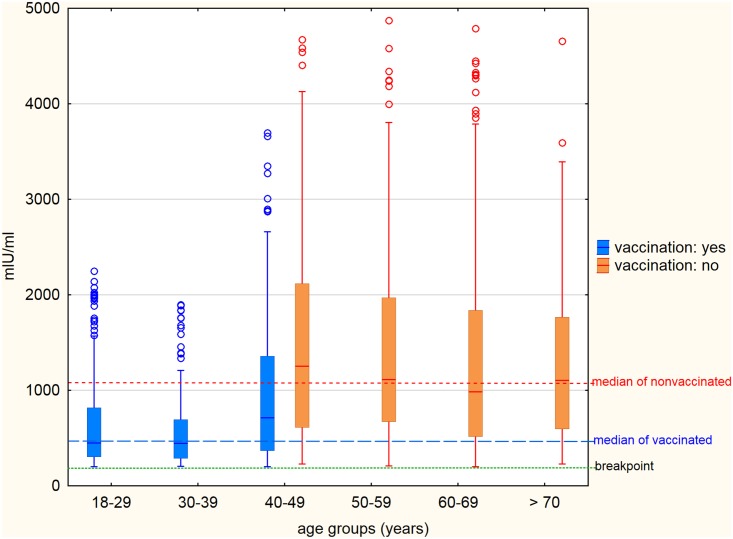
Concentration of IgG antibodies against measles in individual age groups of vaccinated and unvaccinated seropositive persons.The line inside the box shows the median for each group, the lower and the upper edge of the box indicate 25% and 75% percentile, the distance between them (IQR—inter-quartile range) is a measure of the dispersion of values. The ends of the line segments indicate 1.5 times the IQR and values that occur outside these boundaries, are considered outliers.